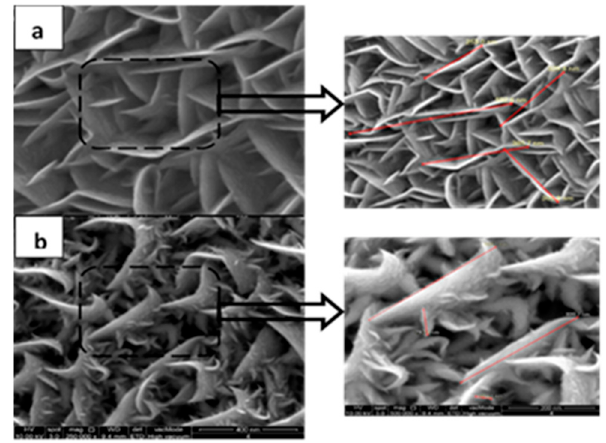
Figure 11. Highly magnified FESEM image of as-grown WS 2 at different gas flow rates ( a ) 5 sccm and ( b ) 7 sccm .